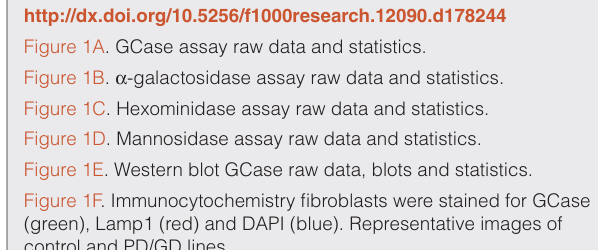
Figure 1A. GCase assay raw data and statistics. Figure 1B. α -galactosidase assay raw data and statistics. Figure 1C. Hexominidase assay raw data and statistics. Figure 1D. Mannosidase assay raw data and statistics. Figure 1E. Western blot GCase raw data, blots and statistics. Figure 1F. Immunocytochemistry fibroblasts were stained for GCase (green), Lamp1 (red) and DAPI (blue). Representative images of control and PD/GD lines. Figure 1G. Gold nanoparticles, images, raw data and statistics. Dataset 2. Raw data underlying the results presented in Figure 2 http://dx.doi.org/10.5256/f1000research.12090.d178246 Figure 2A. Western blots for autophagy assay with iPD, PD GBA, PD/GD and control. Figure 2B. Western blots for autophagy assay with GD. Figure 2C. Autophagy assay